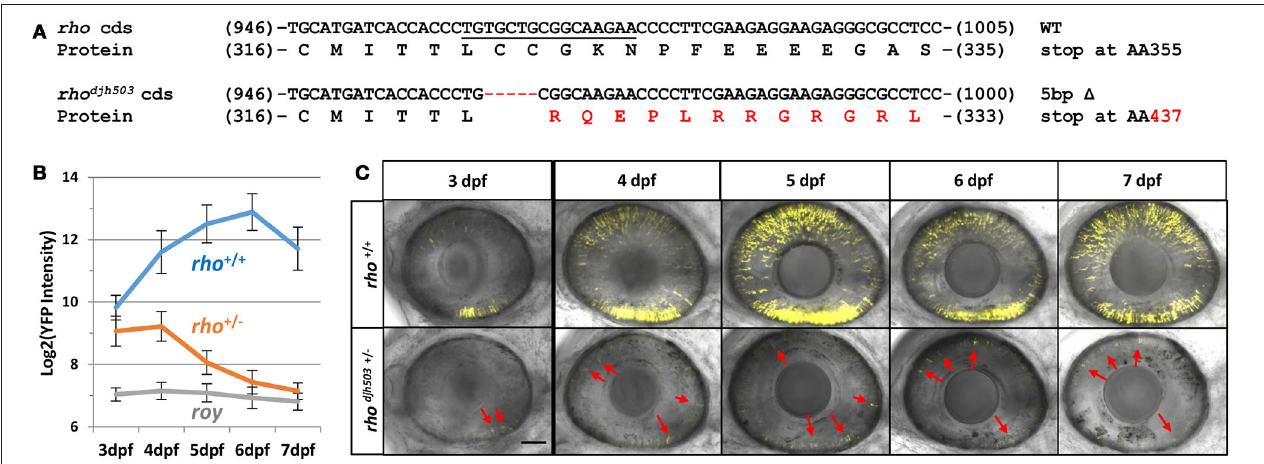
FIGURE 2 | Genotype and phenotype of the CRISPR/Cas9-induced rho djh503 mutation. (A) Sequence of the wildtype rho coding sequence targeted by CRISPR/cas9 (sgRNA sequence underlined) and the location of the 5 bp deletion in the rho djh503 mutant allele. The amino acid sequences predicted to result from these open reading frames are shown below the nucleotide sequence with the altered sequence highlighted in red. (B) YFP signal intensity changes in rho + / + fish and rho djh503 + / − mutant fish from 3 to 7 dpf ( ± sd). Daily fluorescence microplate readings of rho + / + fish and rho djh503 + / − mutants in the rho:YFP-NTR background. The roy control group have no YFP-expressing transgene. Pairwise comparisons (i.e., T -test followed by Bonferroni correction for multiple comparisons) between per day data points produced p -values of ≤ 0.0005. (C) Composite maximum intensity projection images of confocal Z-stacks taken of the eyes of wildtype and mutant fish from 3 to 7 dpf. 3, 4, and 5 dpf images were taken with a 2x zoom while the 6–7 dpf images were taken with a 1.8x zoom. Several of the photoreceptors present in the mutant retinas are indicated by red arrows. The scale bar represents 50 µ m in the 3–5 dpf images and 55.6 µ m in the 6 and 7 dpf images. AA, amino acid; bp, base pair; cds, coding sequence; dpf, days post-fertilization; WT, wildtype; YFP, yellow fluorescent